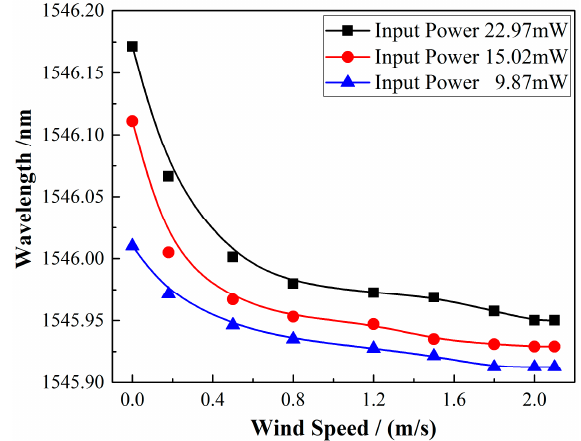
Figure 10. Wavelength responses versus the wind speed of the anemometer under different input powers.